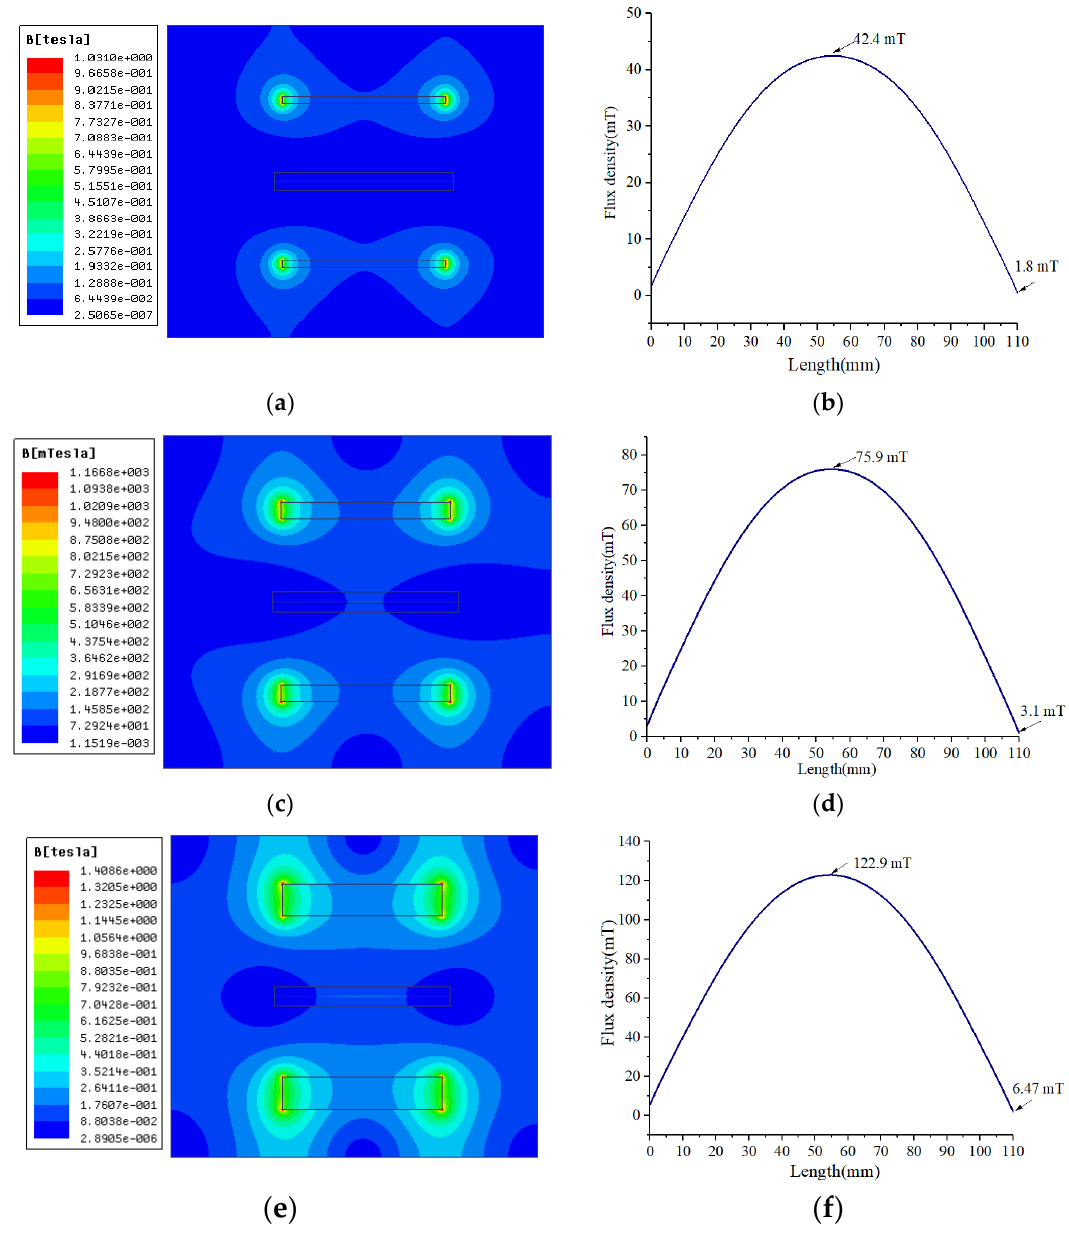
Figure 5. Simulation results of flux density. ( a ) Two-dimension distribution at 42.4 mT. ( b ) Flux density at the middle of superconducting tapes at 42.4 mT. ( c ) Two-dimension distribution at 75.9 mT. ( d ) Flux density at the middle of superconducting tapes at 75.9 mT. ( e ) Two-dimension distribution at 122.9 mT. ( f ) Flux density at the middle of superconducting tapes at 122.9 mT.